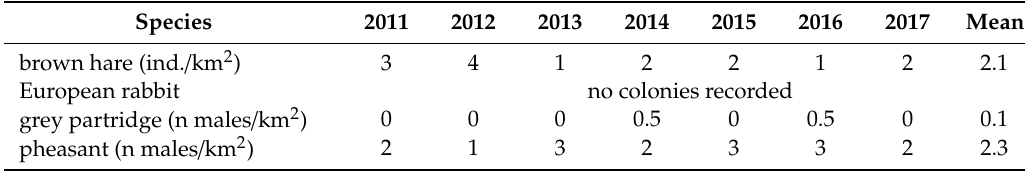
Table A2. The changes in the density of small game species in the area of study (central Poland, vicinity of Rog ó w village, Experimental Forest Station of Warsaw University of Life Sciences) in the current study period